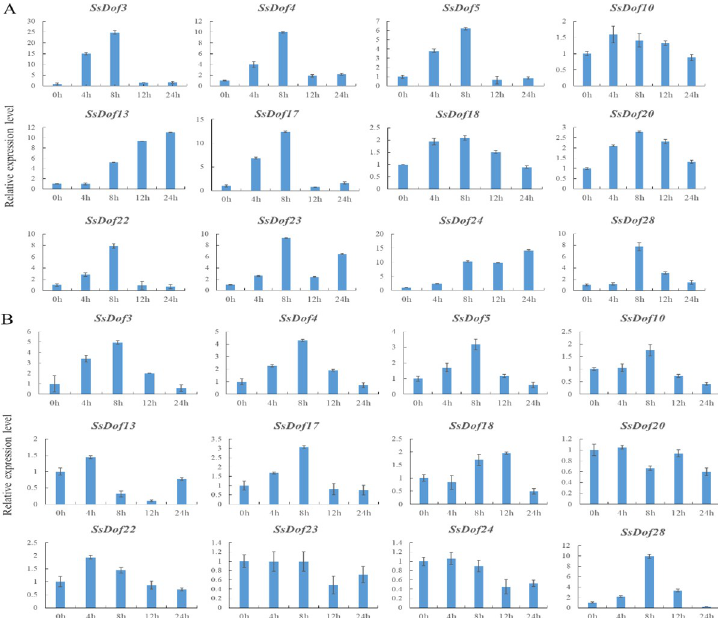
Fig 9. Expression levels of SsDof genes under cold and heat treatments by qRT-PCR. The tissue samples were obtained from leave in seeding stage (45 days old). The standard deviation was indicated with the vertical bars. (A). The sugarcane seedlings were performed with 4˚C for 4, 8, 12 and 24 h respectively. (B). The sugarcane seedlings were performed with 38˚C for 4, 8, 12 and 24 h respectively.